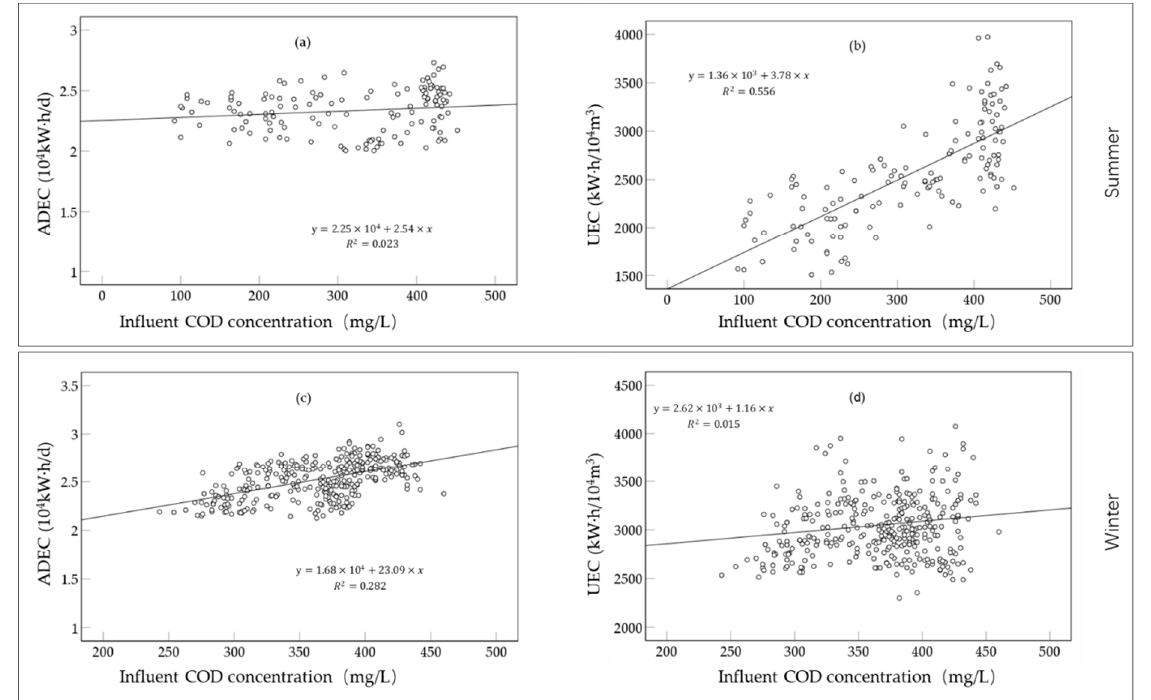
Figure 12. Variation of electricity consumption with influent wastewater COD concentration in different seasons. (Variation of ( a ) ADEC and ( b ) UEC in summer; Variation of ( c ) ADEC and ( d ) UEC in winter).